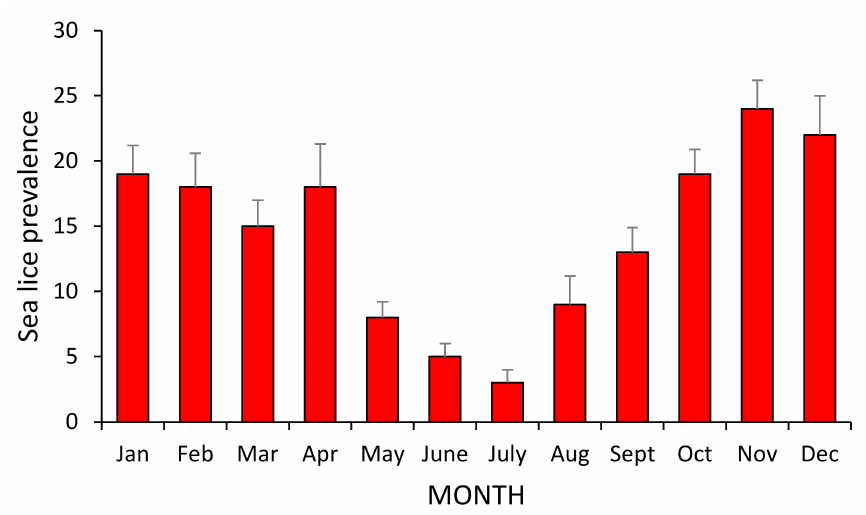
Figure 7. Average monthly prevalence of sea lice in lumpfish stomachs in Faroese salmon farms. Vertical bars indicate standard error (SE). Data modified from